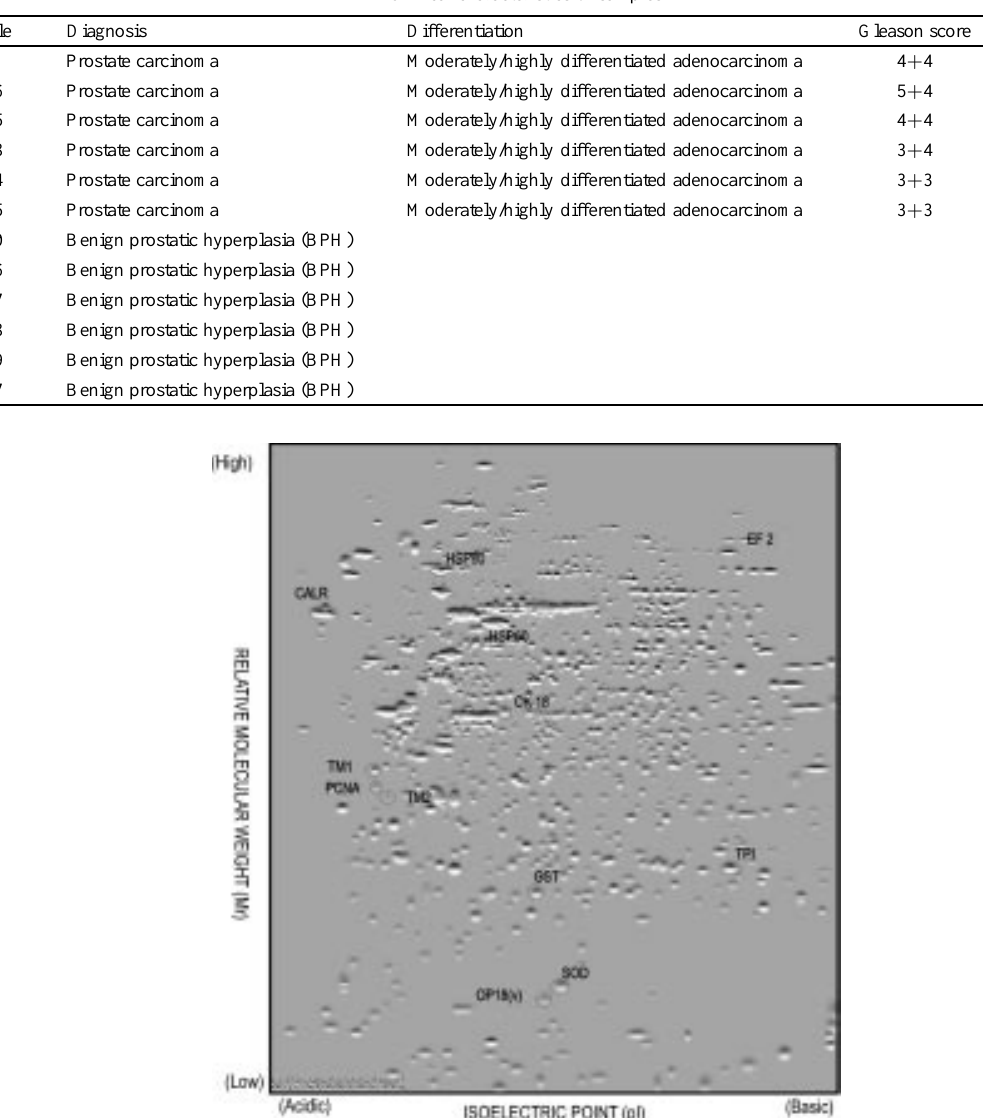
Clinical characteristics of samples